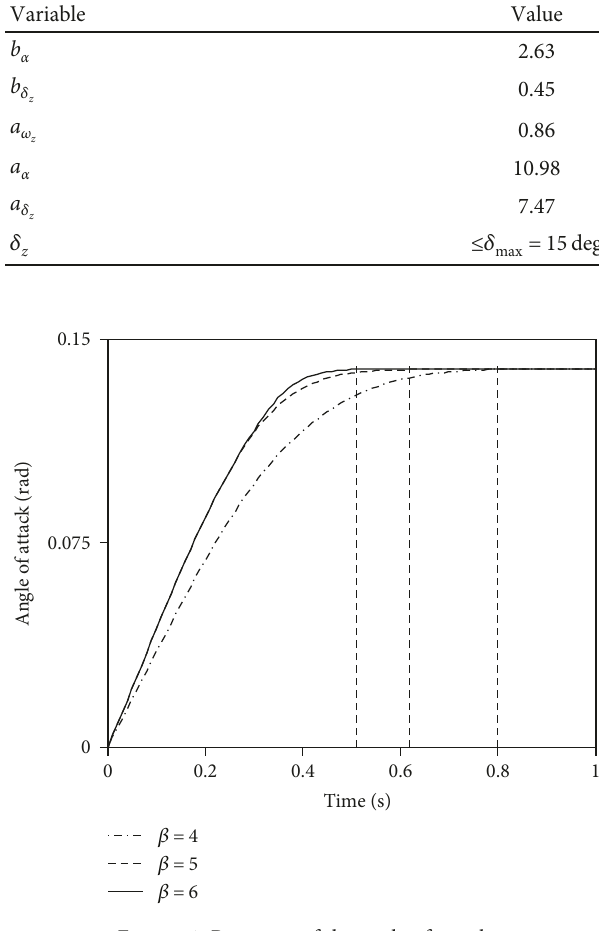
Figure 1: Response of the angle of attack.